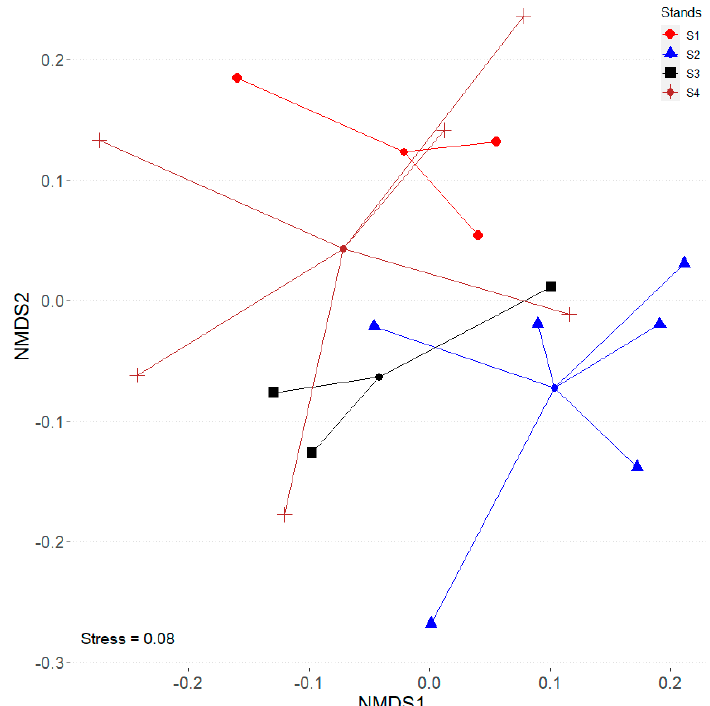
Figure 4. Nonmetric multidimensional scaling (nMDS) showing Pilgerodendron uviferum stands sampled in the Magellanic islands of Kawésqar National Park.